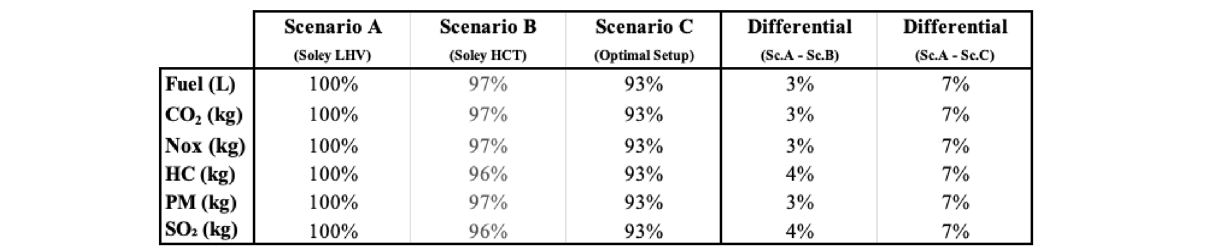
Table 4 Environmental